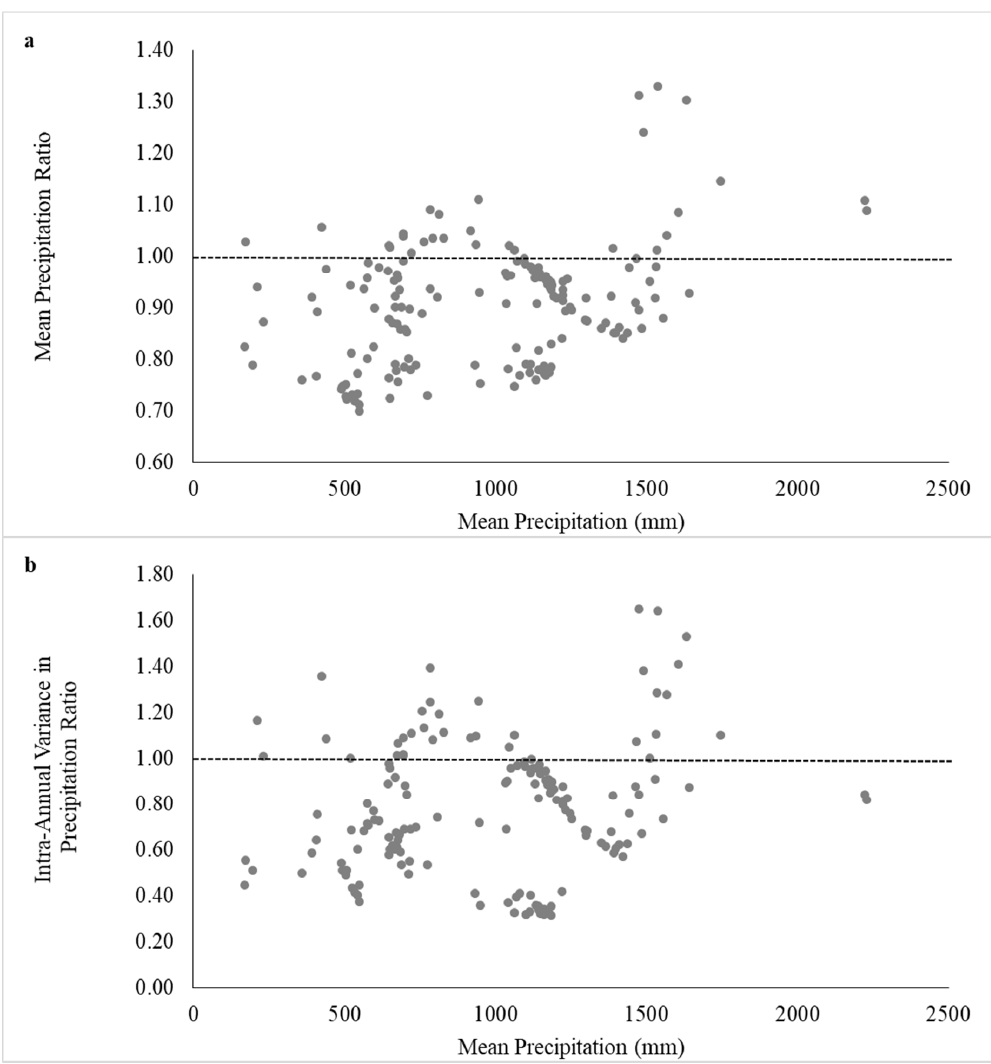
Figure 3. Temporal variation in climate (precipitation) variables in the sample. ( a ) Ratio between observed and historical annual average precipitation levels for each wastewater treatment plant with respect to historical annual average precipitation levels; ( b ) Ratio between observed and historical intra-annual variation in precipitation for each wastewater treatment plant with respect to historical intra-annual variation in precipitation.